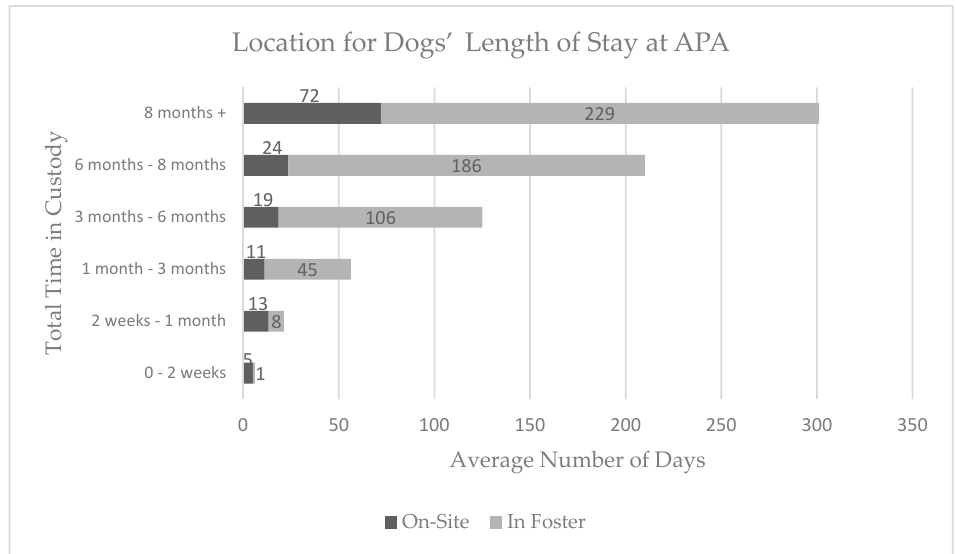
Figure 3. The average time spent in foster care versus on-site at APA for each range of total length of stay (time in custody) for the 122 dogs in the sample.